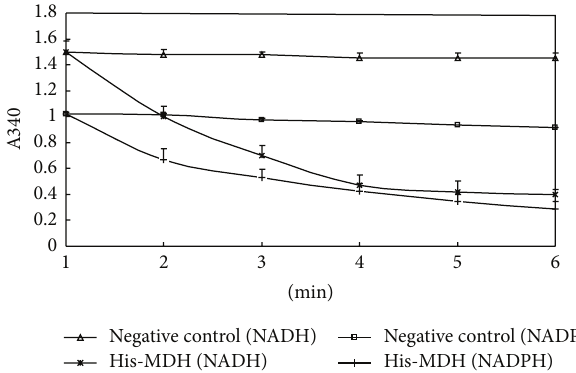
Figure 3: Enzymatic analysis of B. abortus His-MDH. One micro- gram of purified His-MDH was added to the reaction buffer and the enzymatic kinetics was measured. The enzymatic activity was detected as detailed in Materials and Methods. The experiments were performed in triplicate, and the bars represent standard